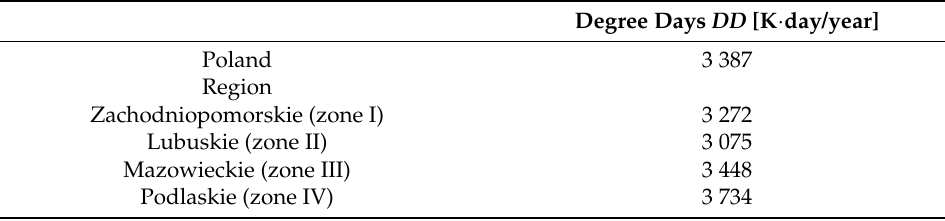
Table 4. Average values of the degree days of the heating period for Poland and selected regions.